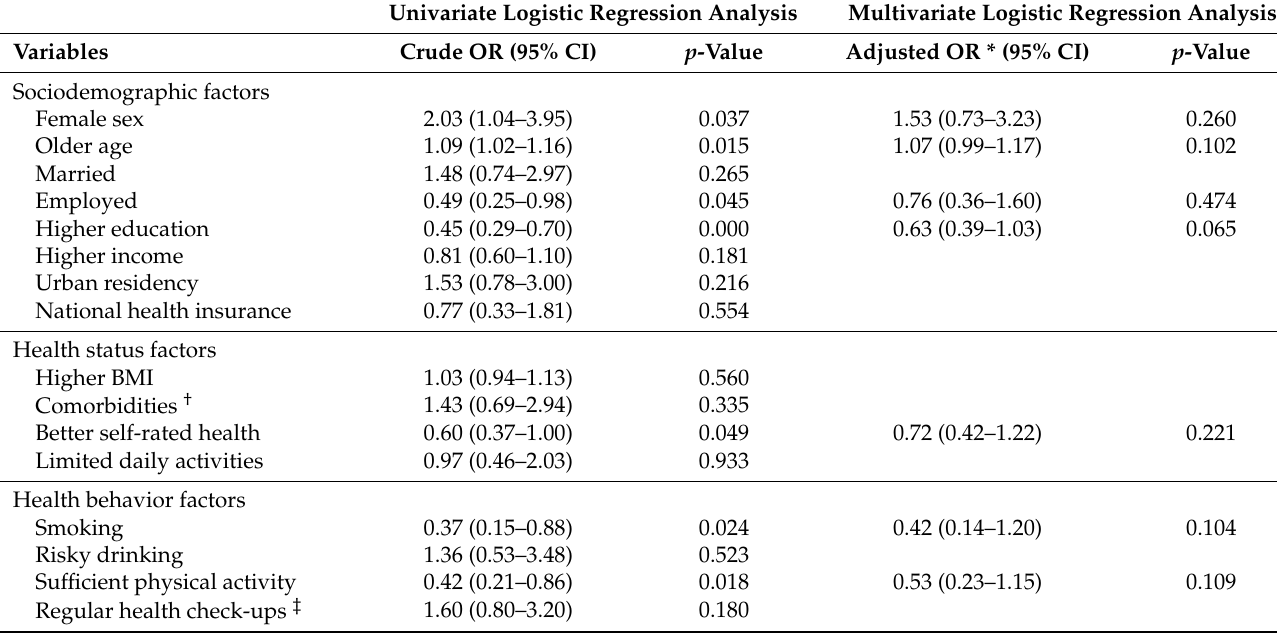
Table 4. Factors associated with influenza vaccination status among stroke survivors aged less than 65 years (n = 199). Univariate Logistic Regression